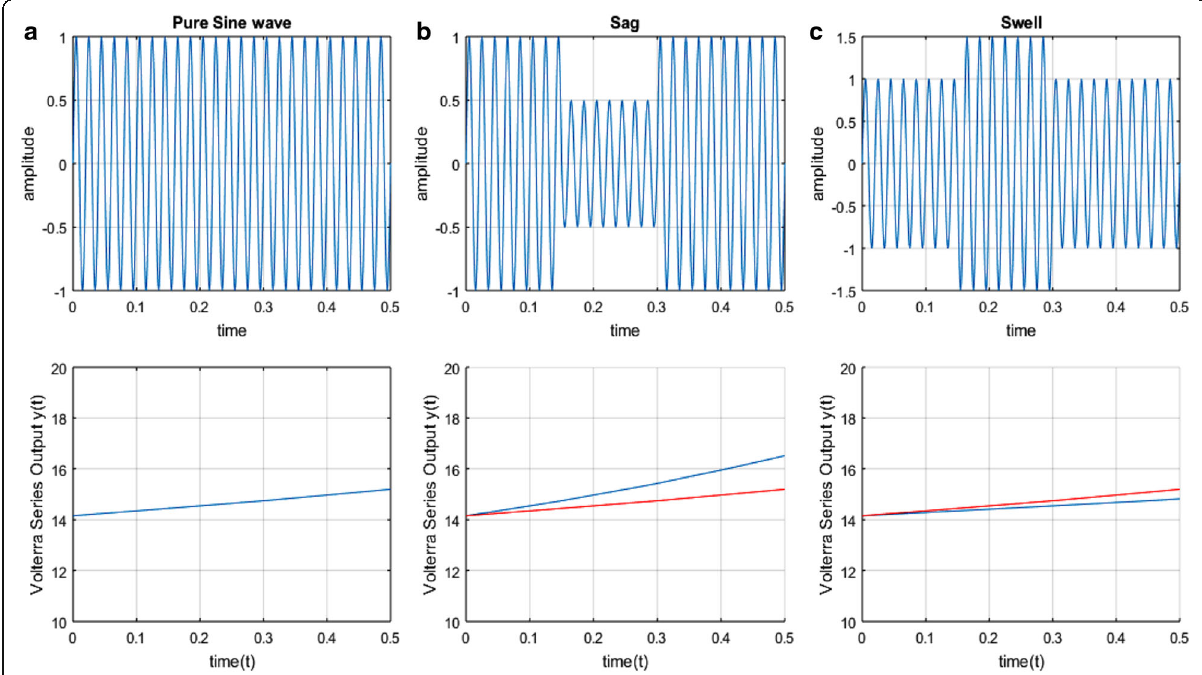
Fig. 1 Volterra series output for a Pure sine wave b Sag c